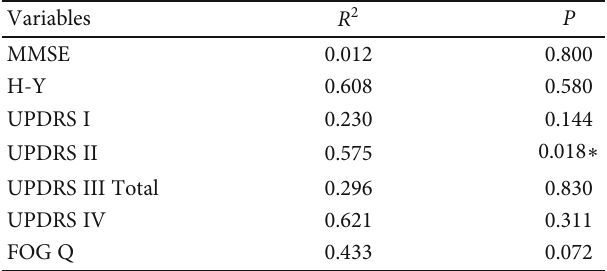
Table 2: Linear regression results between CTh of rMTG and clinical